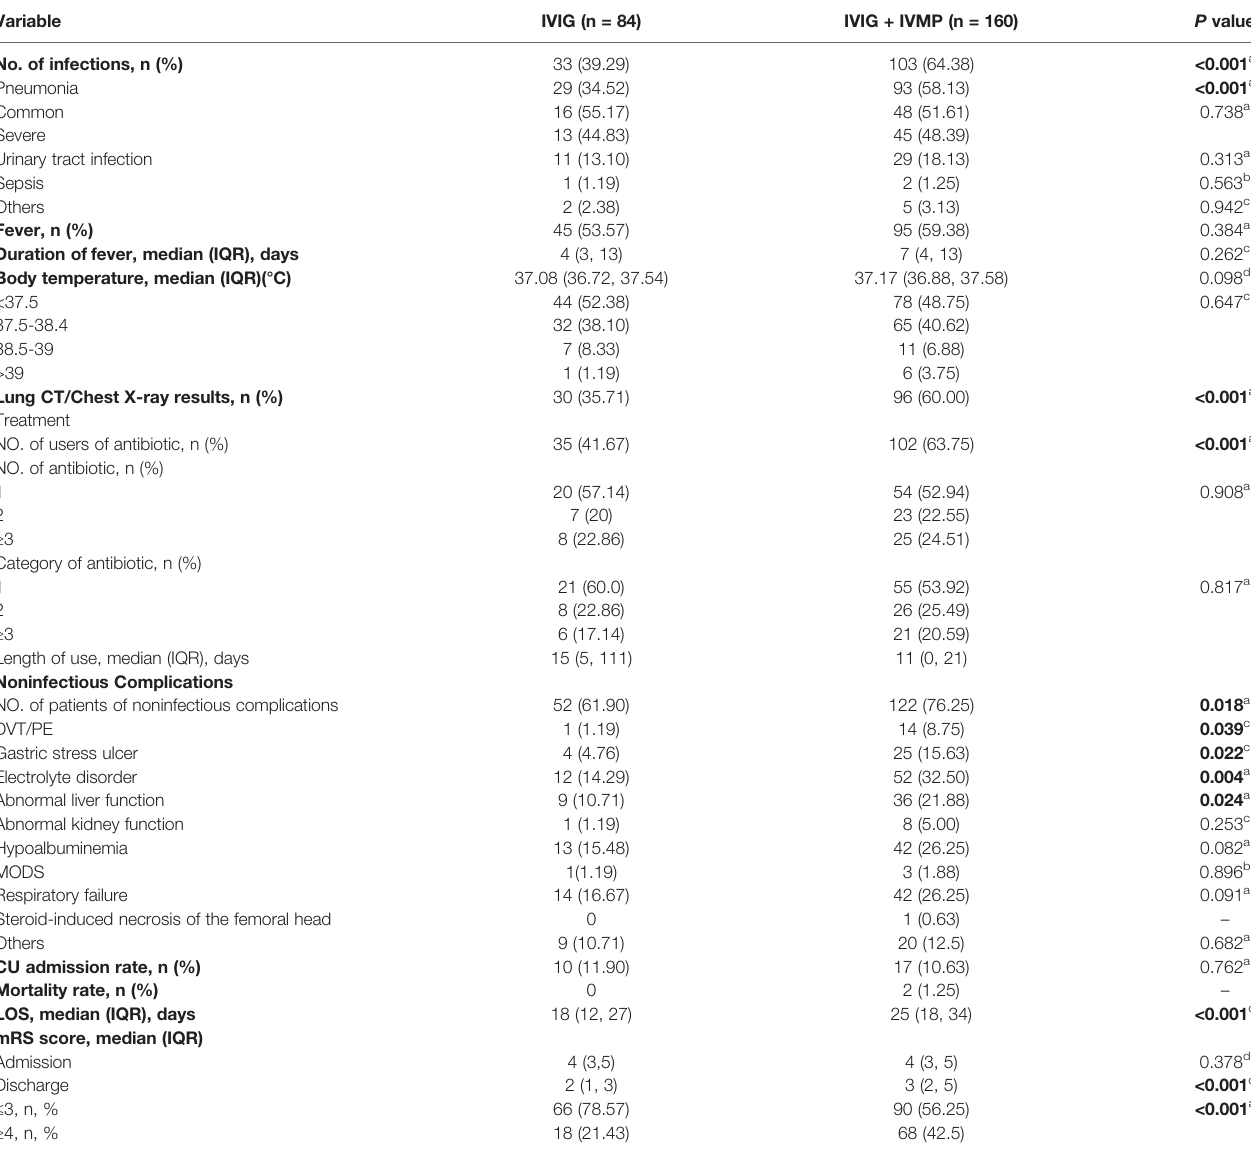
TABLE 2 | Characteristics of complications and outcomes of anti-NMDAR encephalitis patients in both groups.